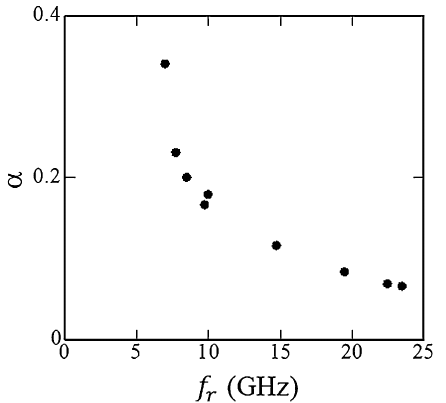
Figure 5. Gilbert damping constant, α , as a function of the resonance frequency ( f r ). f r values are obtained from Fig. 4g. On the other hand, α values are determined by the µ ′′ − f profiles from method (ii) using Eq.